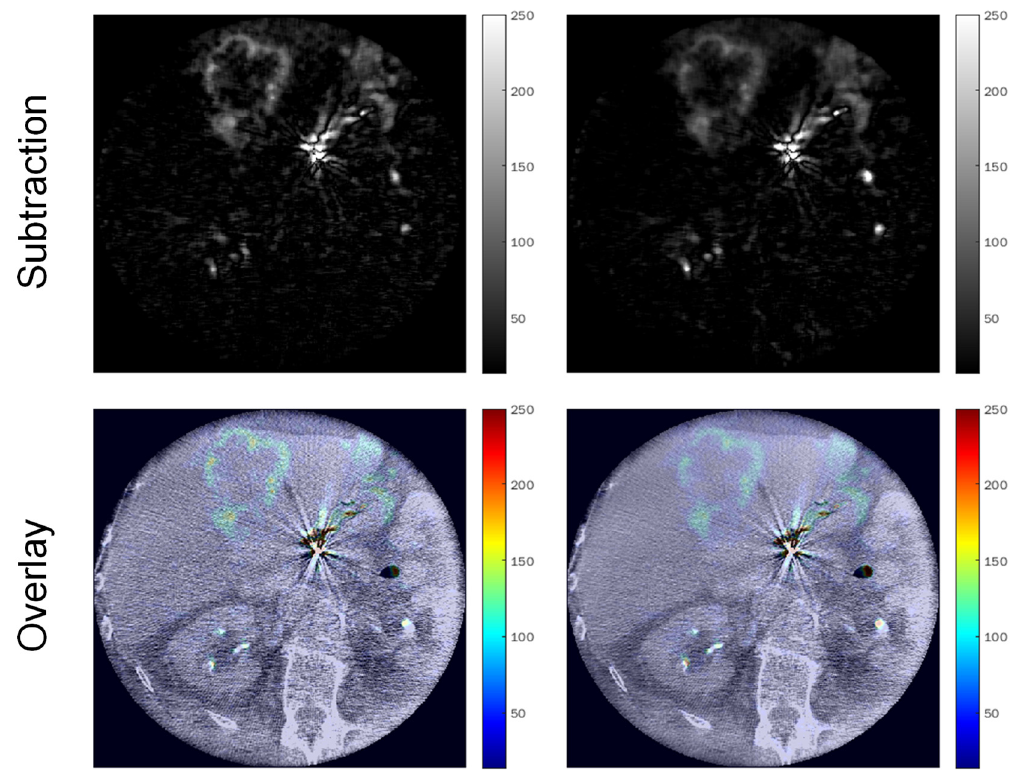
Figure 7. Example images of a 68-year-old adipose male patient (BMI = 30) undergoing SIRT for hepatic uveal melanoma metastases.